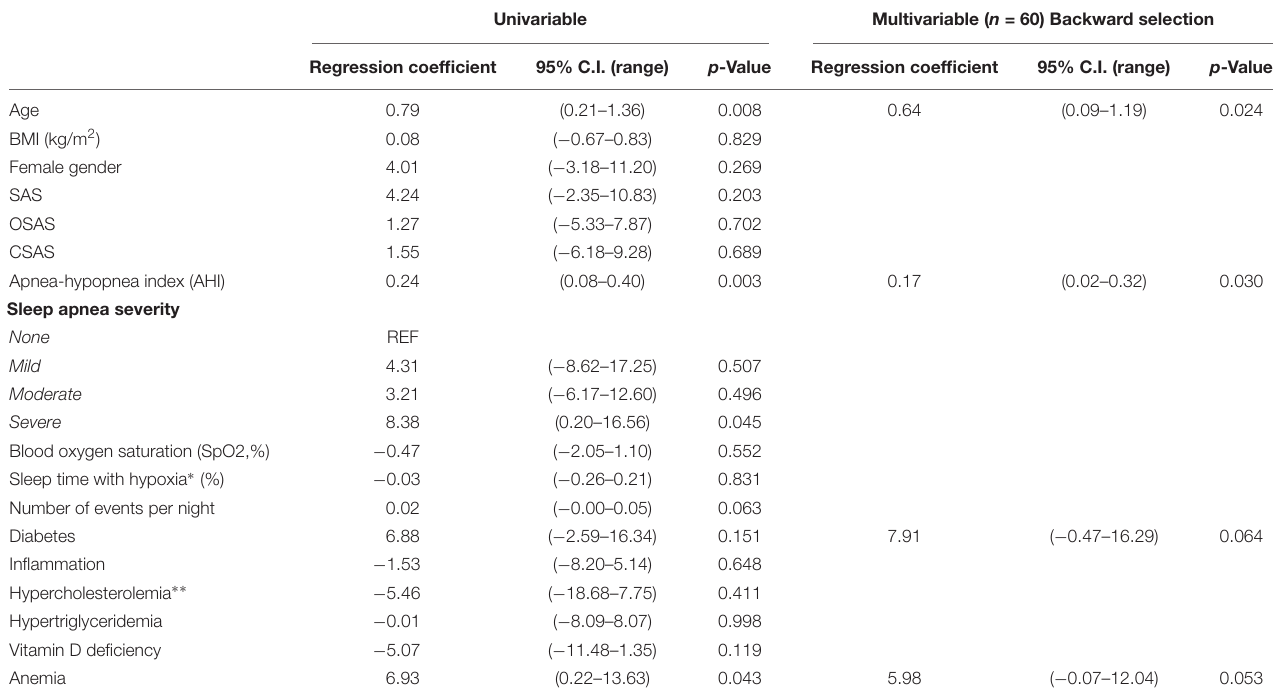
TABLE 6 | Uni- and Multi-variable regression to identify factors associated with the Stroop Colors Test (delay,